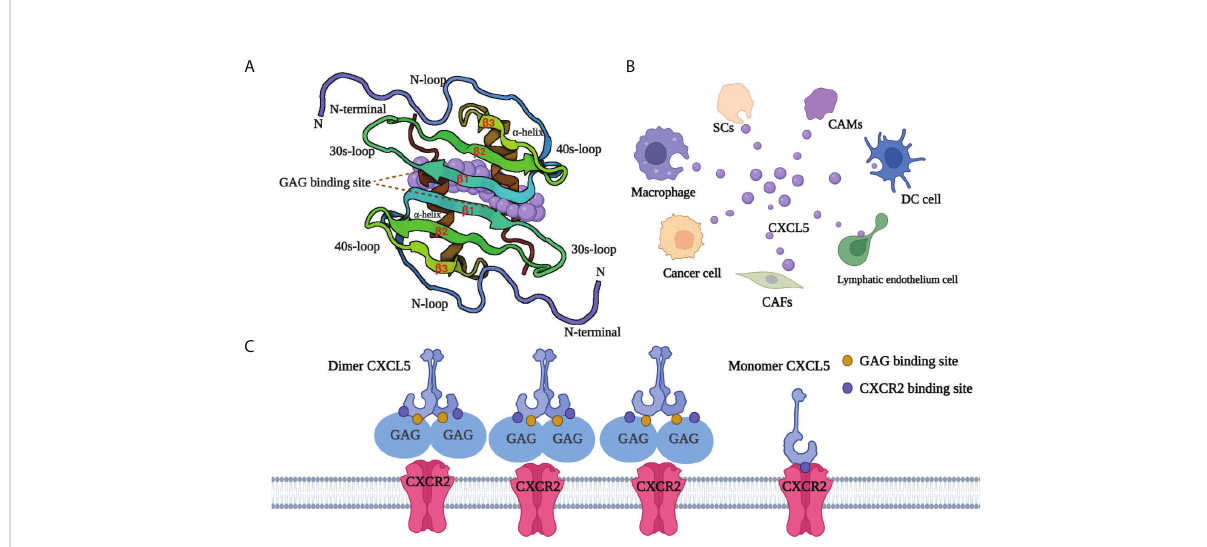
FIGURE 1 Structure and GAG-binding region of CXCL5. (A) The protein dimer comprises of a six-stranded antiparallel b -sheet and a pair of a -helices. The monomer structure consists of an extended N-terminal loop (N-loop) followed by three b - strands and a terminal a -helix. (B) CXCL5 can be secreted by various cells, including tumor cells, immune cells, and other non-immune cells. Cancer-associated mesothelial cells (CAMs), cancer-associated fi broblasts (CAFs), dendritic cells (DC cell), Schwann cell (SCs). (C) The GAG-binding region and CXCR2-binding region overlap. GAG-bound CXCL5 is unable to activate the receptor CXCR2. CXCL5, C ‐ X ‐ C motif chemokine ligand 5; CXCR2, C ‐ X ‐ C motif chemokine receptor 2; SCs, Schwann cells; CAMs, cancer-associated mesothelials; DC cell, dendritic cell; CAFs, cancer-associated fi broblasts; GAG,